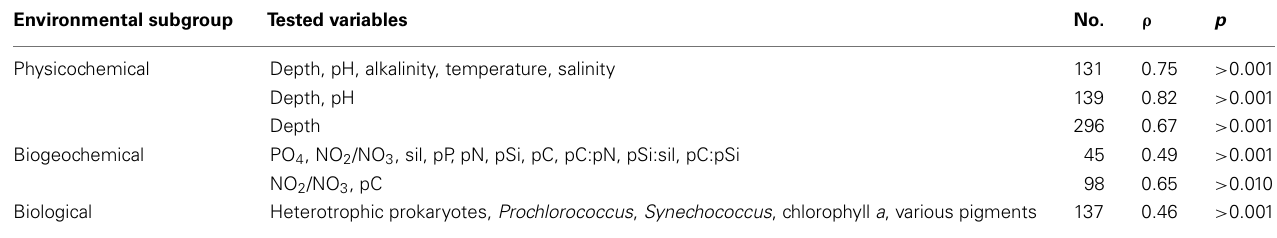
Table 3 | Statistical analysis of correspondence between bacterioplankton community structure and environmental parameters. Environmental